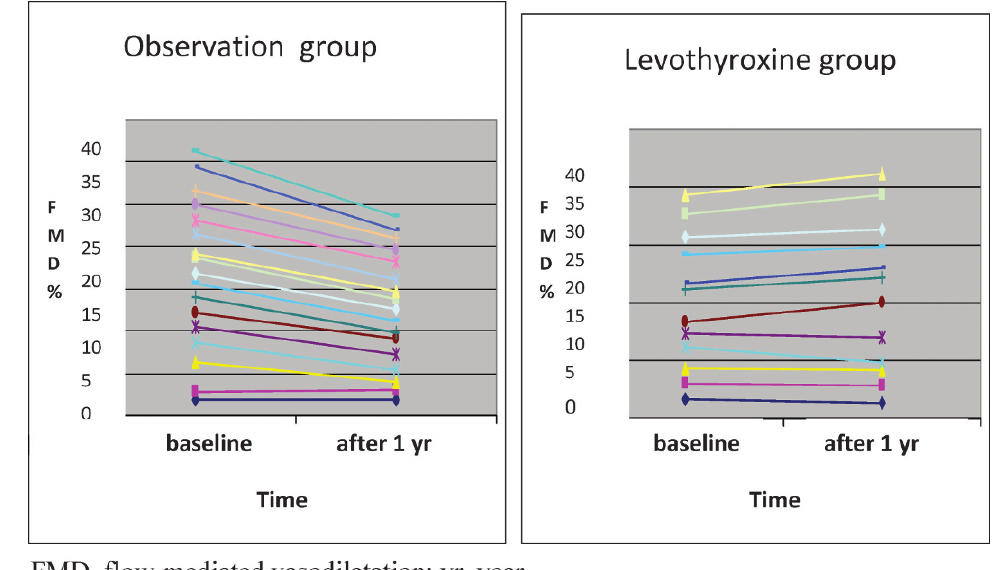
Figure 1 - Changes in FMD% in the levothyroxine-treated and